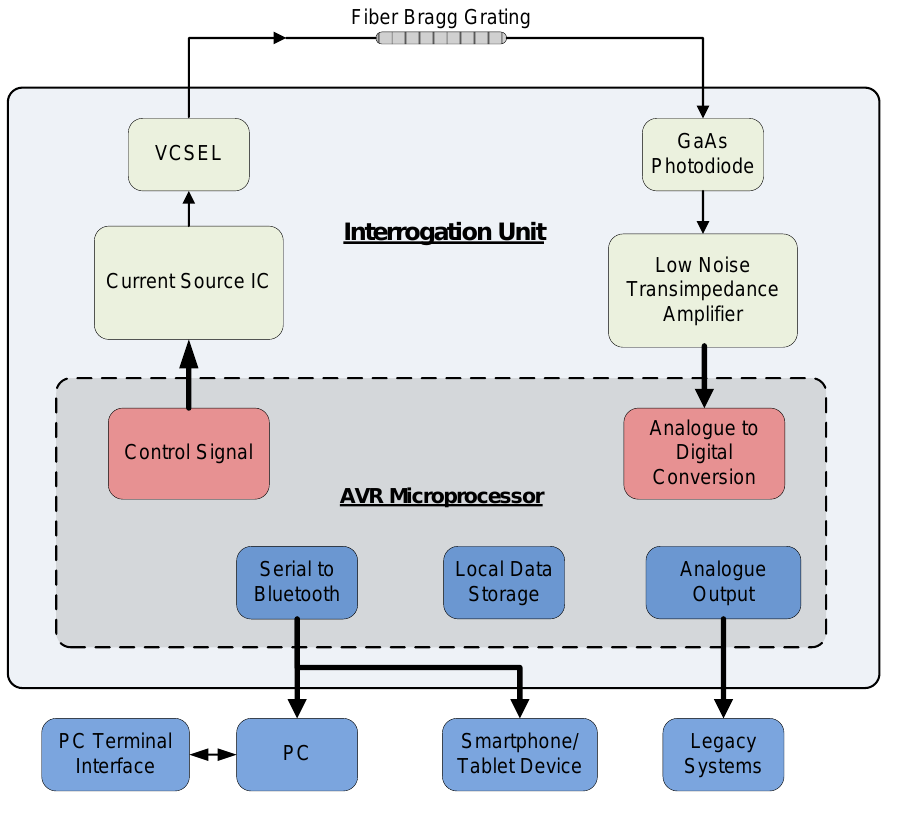
Figure 4. Detailed schematic view of the proof of concept sensor interrogation